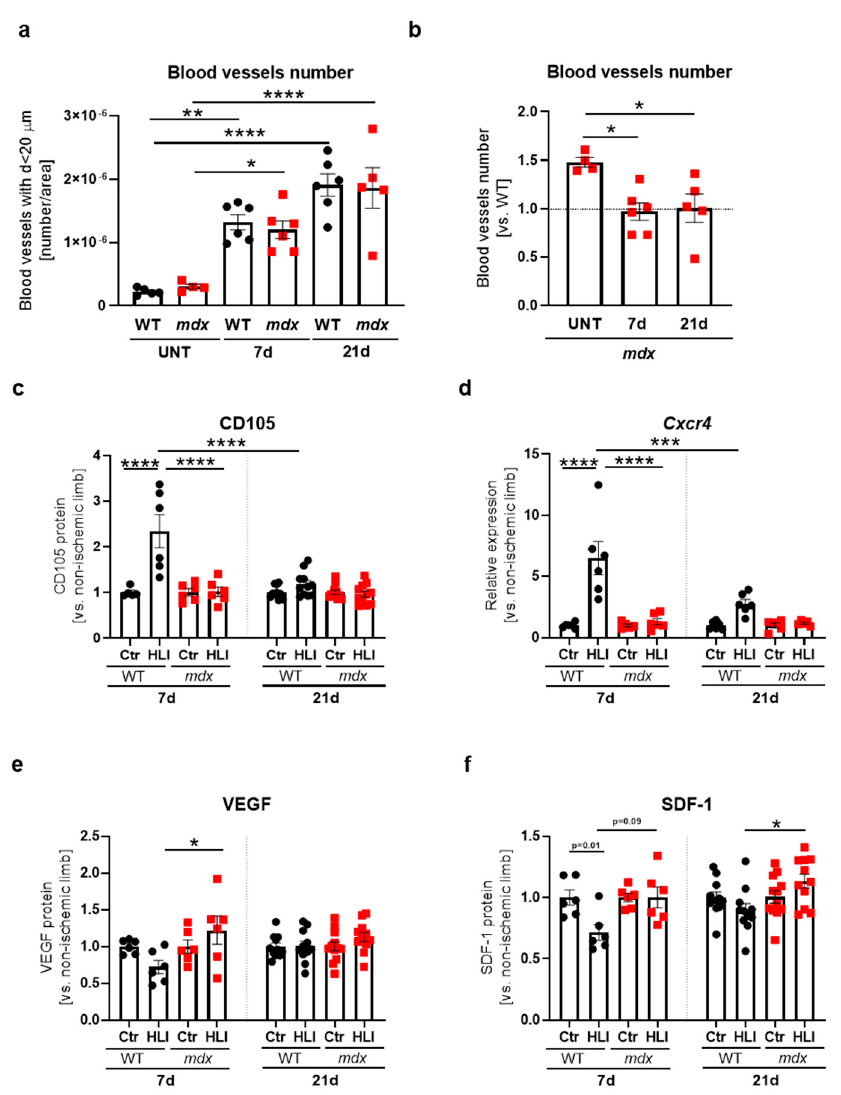
Figure 6. Blood vessels and angiogenic markers in the gastrocnemius of 12-week-old WT and dystrophic mice following hindlimb ischemia (HLI). ( a ) The number of blood vessels with a diameter lower than 20 μ m in untreated (UNT) WT and mdx mice as well as in animals 7 and 21 days after HLI. ( b ) The total number of blood vessels in mdx mice shown in relation to WT mice after HLI; quantification based on immunofluorescent staining of CD31 + α -SMA + double-positive blood vessels; n = 4–6/group. ( c ) The protein level of CD105; ELISA, n = 5–11/group and ( d ) Cxcr4 transcript; qRT-PCR, n = 5–6/group. ( e ) Vascular endothelial growth factor (VEGF); ELISA, n = 6–12/group and ( f ) stromal derived factor-1 (SDF-1); ELISA; n = 6–12/group in the gastrocnemius of WT and mdx mice 7 and 21 days after HLI. The results are presented as mean ± SEM. * p < 0.05, ** p < 0.01, *** p < 0.005, **** p < 0.0001 by one-way ANOVA with Tukey’s posthoc test.